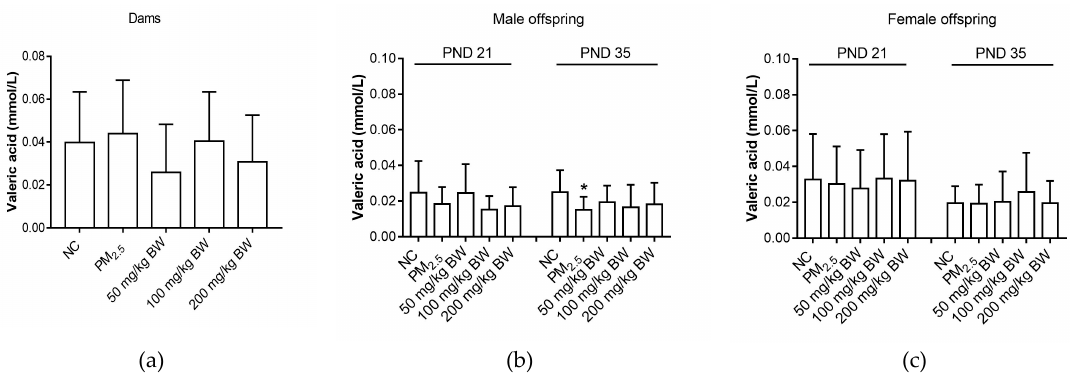
Figure 6. Valeric acid concentrations of dams and offspring. (a) Valeric acid of dams on PND 21. (b) Valeric acid of male offspring on PND 21 and PND 35. (c) Valeric acid of female offspring on PND 21 and PND 35. The data was expressed as mean ± SD of each group. Compared with the NC group, * indicates p < 0.05.